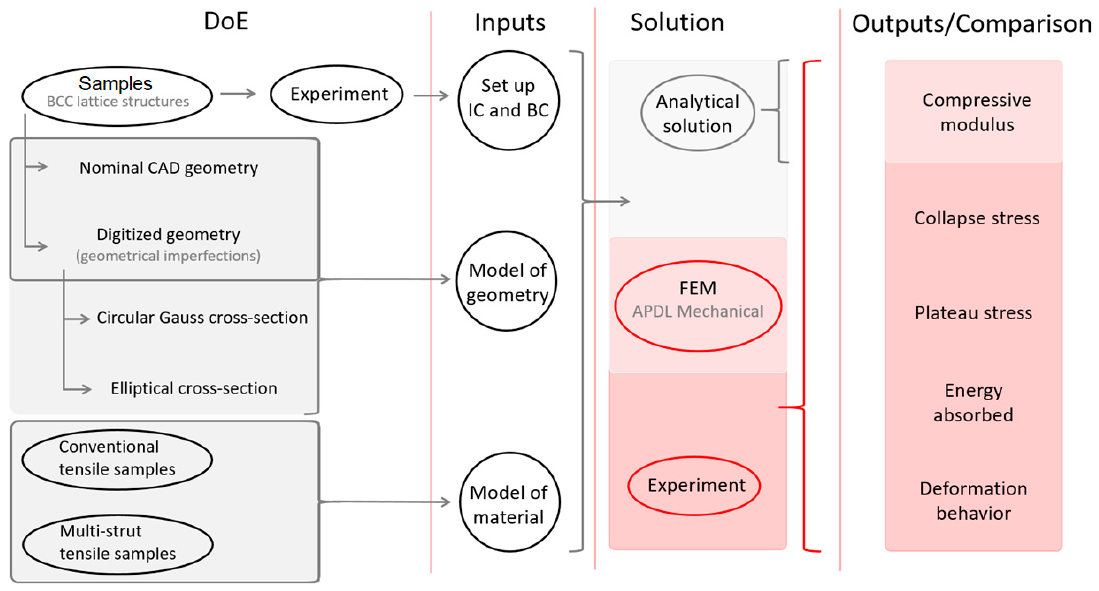
Figure 1. Scheme of the main working points in study.